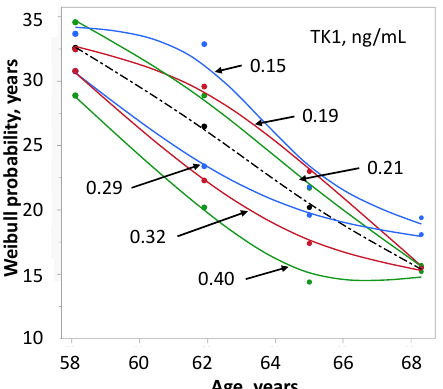
Figure 6. Influence of TK1 concentration on survival probability of 175 men with prostate cancer stratified by age. The survival probability was calculated from Weibull-transformed Kaplan – Meier estimates. The shattered line shows the survival probability of age alone.